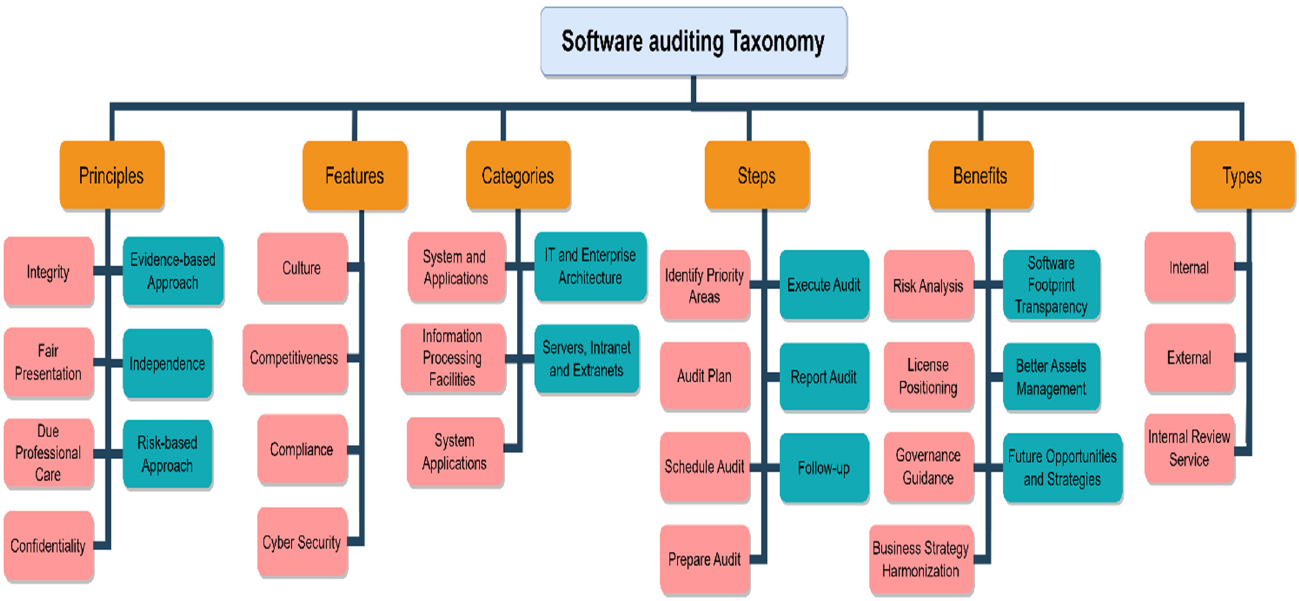
Figure 2. Software audit taxonomy.